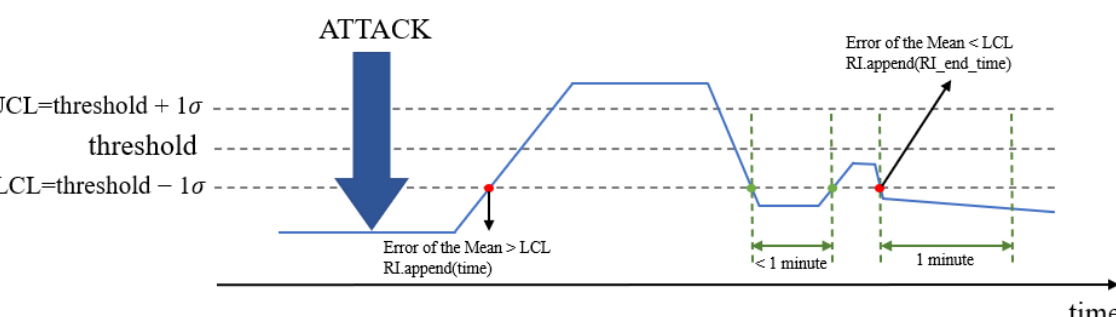
Figure 5. Example of applying the algorithm to the redefinition of the real affected section.